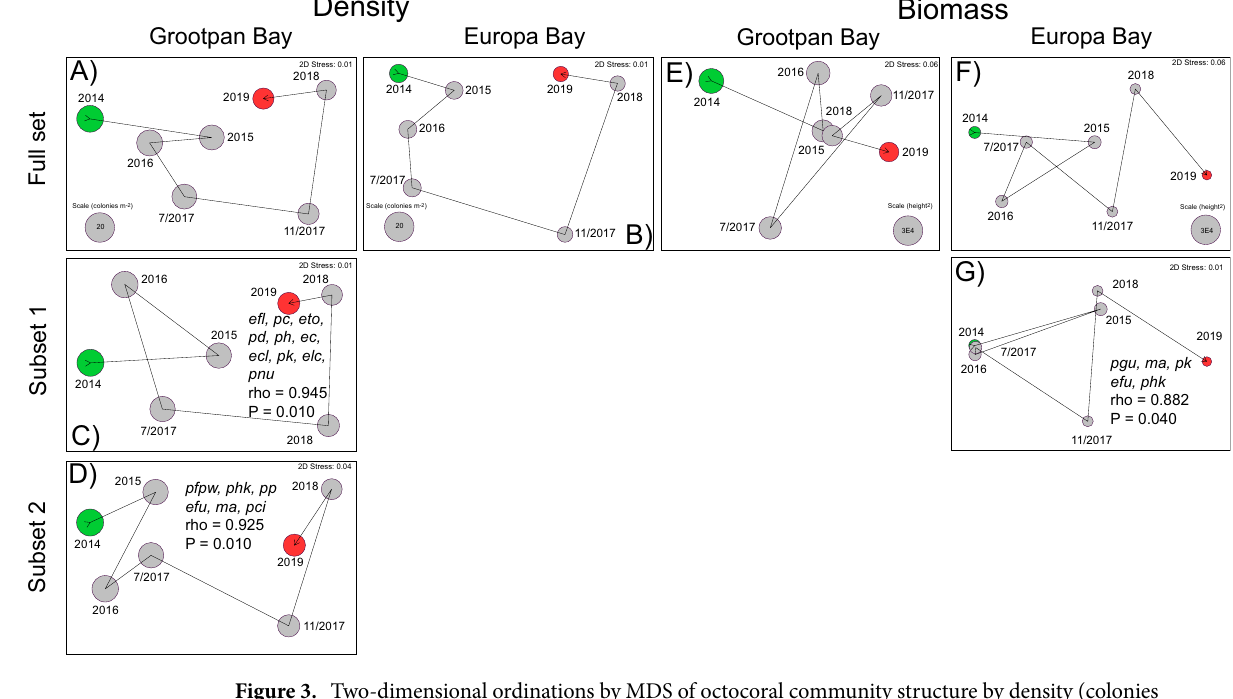
Figure 3. Two-dimensional ordinations by MDS of octocoral community structure by density (colonies m −2 ) and the biomass proxy (height 2 ) for Grootpan Bay and Europa Bay. Ordinations shown for the full species assemblage ( A , B , E , F ) and for the first subsets of species that generate statistically indistinguishable ordinations. Species codes and full analyses in Table 1. No species subsets produced similar ordinations for density at Europa Bay, or for the biomass proxy at Grootpan Bay.